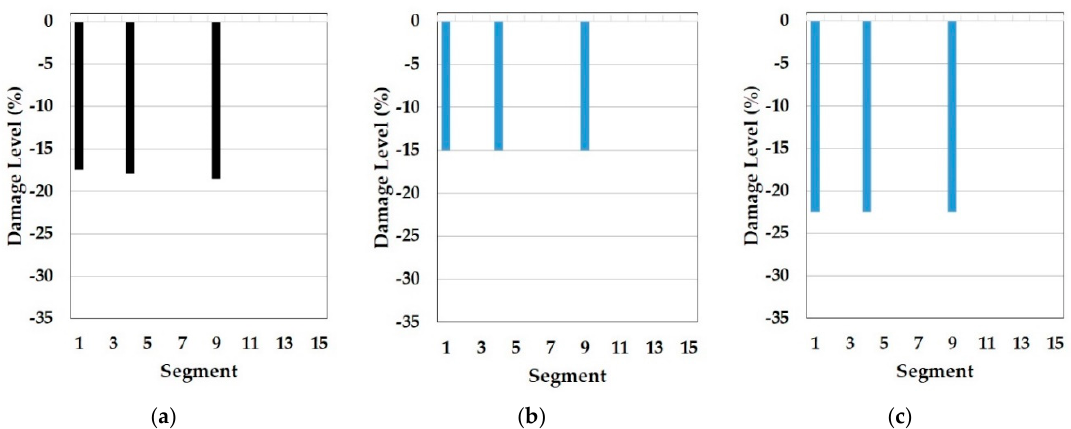
Figure 9. Symmetric baseline model under DS3 (blue color is correct segment whereas orange color is incorrect segment): ( a ) Predicted damage from the GA (black color); ( b ) top one damage case using the first to fourth natural frequencies; ( c ) top two damage case the first to fourth natural frequencies.